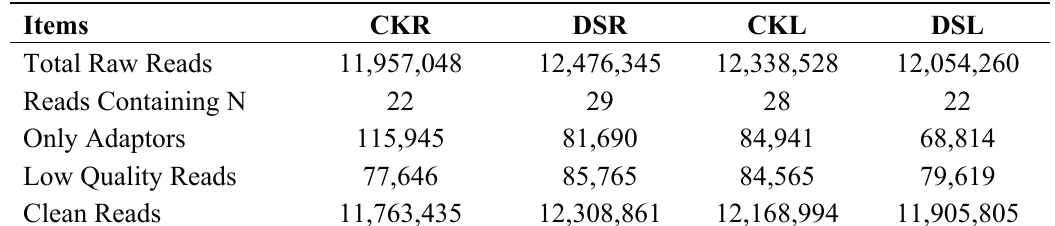
Table 1. Illumina sequencing reads in CK root (CKR), drought stress root (DSR), CK leaf (CKL) and drought stress leaf (DSL)